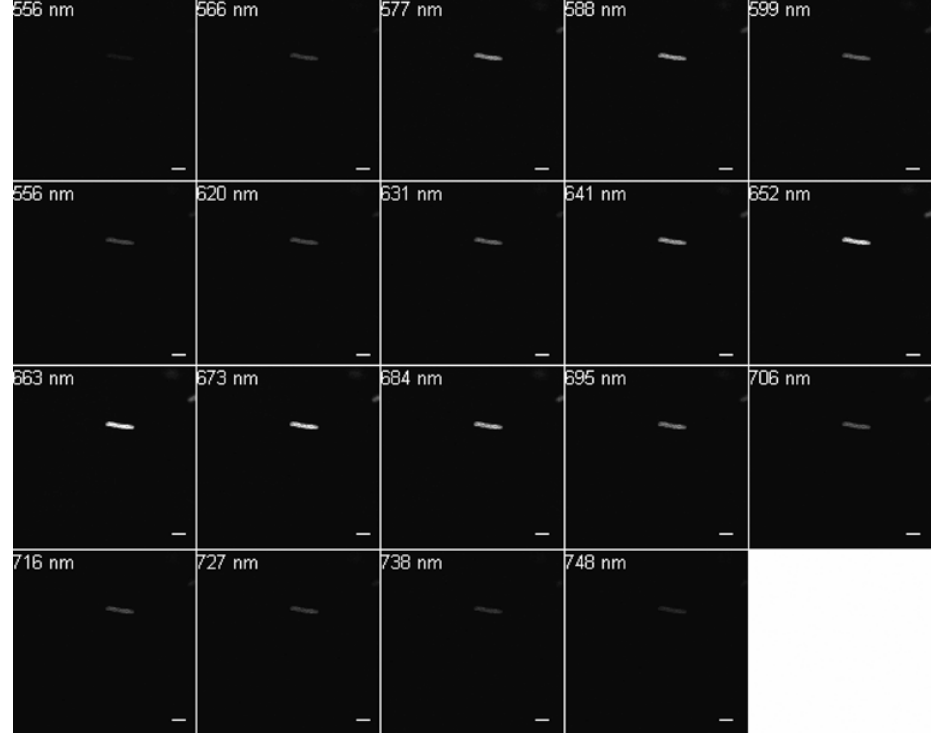
Figure 5. Spectral emission collection of SF33 GL-grown cells after excitation with 543-nm laser. An emission spectrum was gathered at 10.7-nm increments in the range from 550 nm to 750 nm. All images at 63× oil objective. Bars, 10 μm.